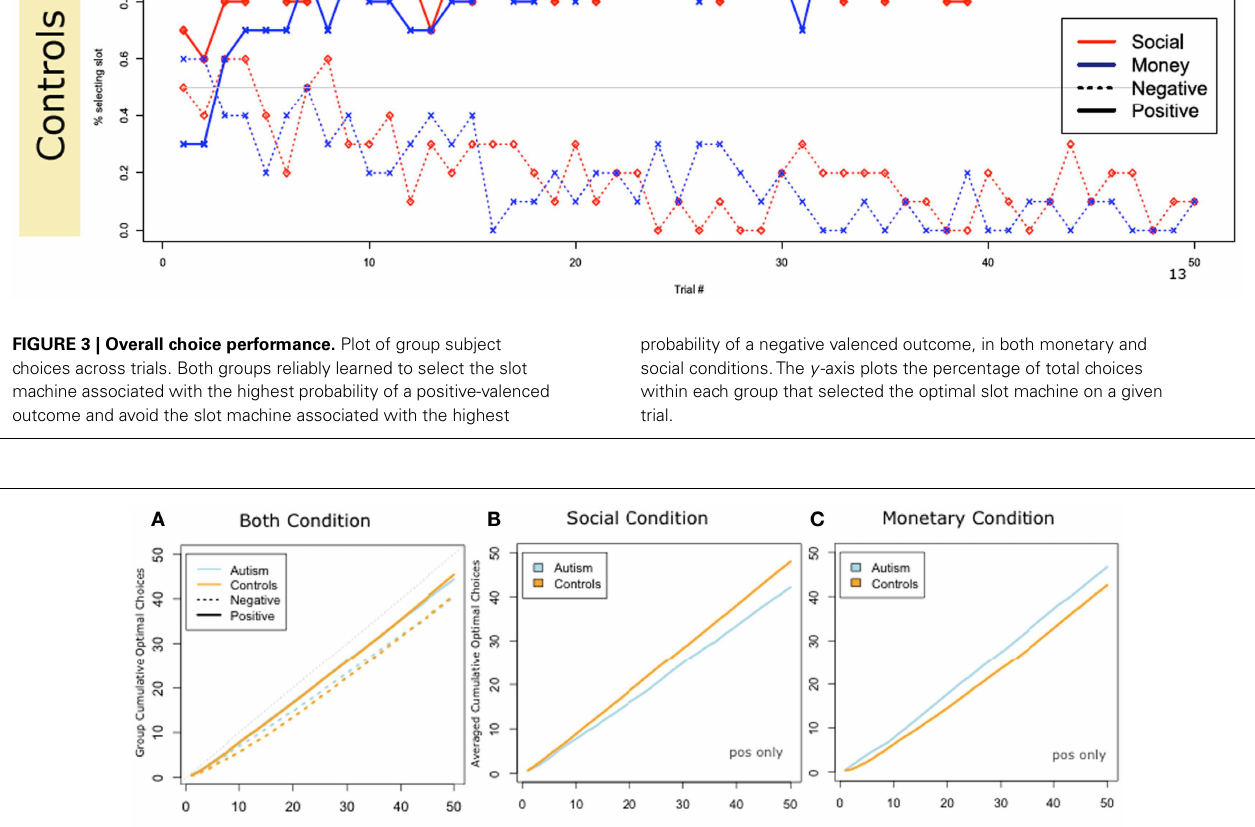
FIGURE 4 | Cumulative choices for positively valenced conditions. (A) Plot of cumulative optimal responses across trials in social condition. (B) Plot of cumulative optimal responses across trials in the social condition. (C) Plot of cumulative optimal responses across trials in the monetary condition.We